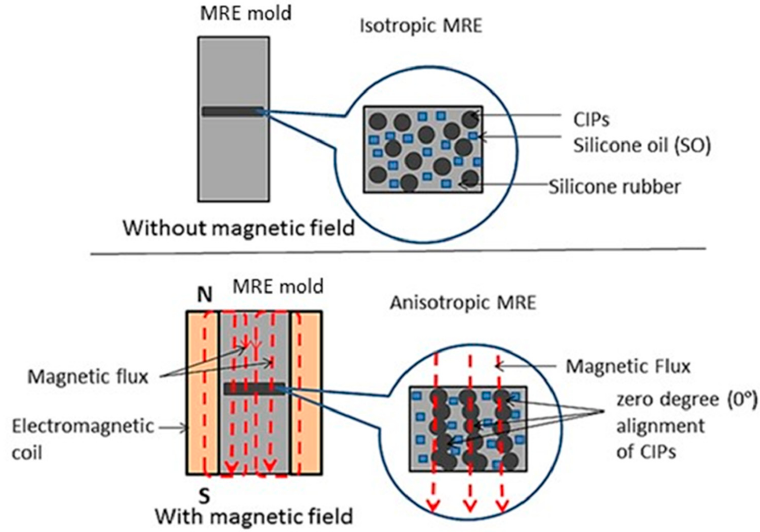
Figure 8. Illustration of the fabrication of the isotropic and anisotropic magnetorheological elastomers (MREs).